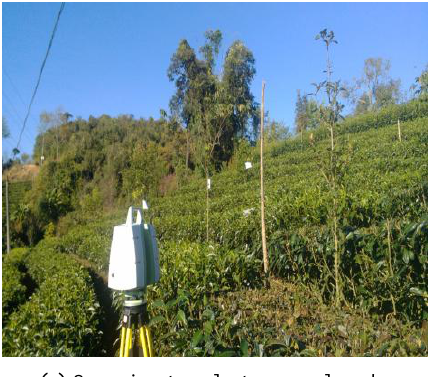
(a) Scanning tea plants on a slope by using the